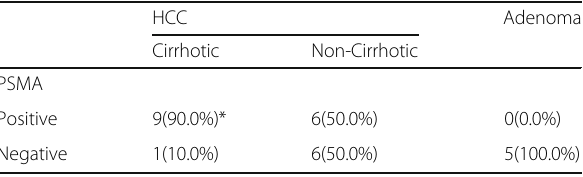
Table 2 PSMA neovascular expression in primary liver tumors